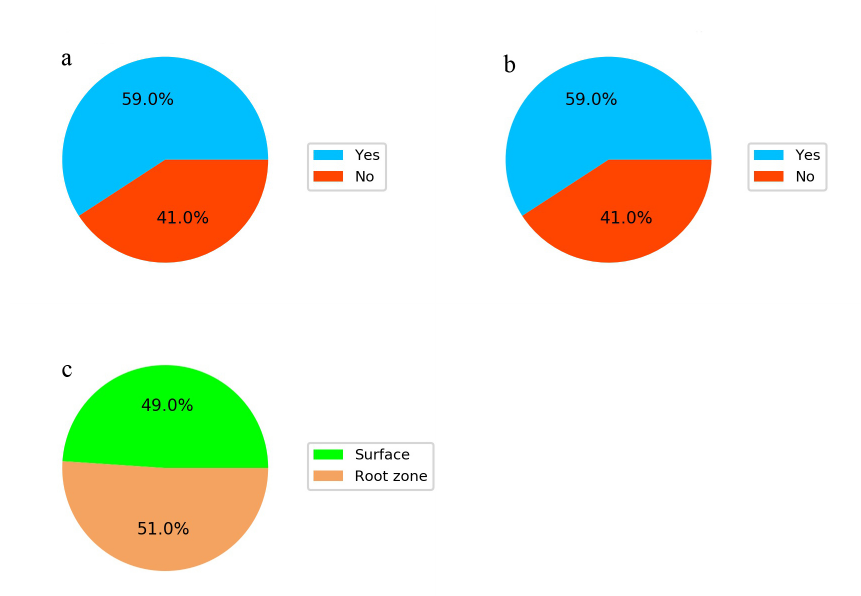
Figure 4. Information related to soil moisture measurement: ( a ) percentage of farmers measures soil moisture by feeling, ( b ) percentage of farmers measures soil moisture by smell, and ( c ) depth of